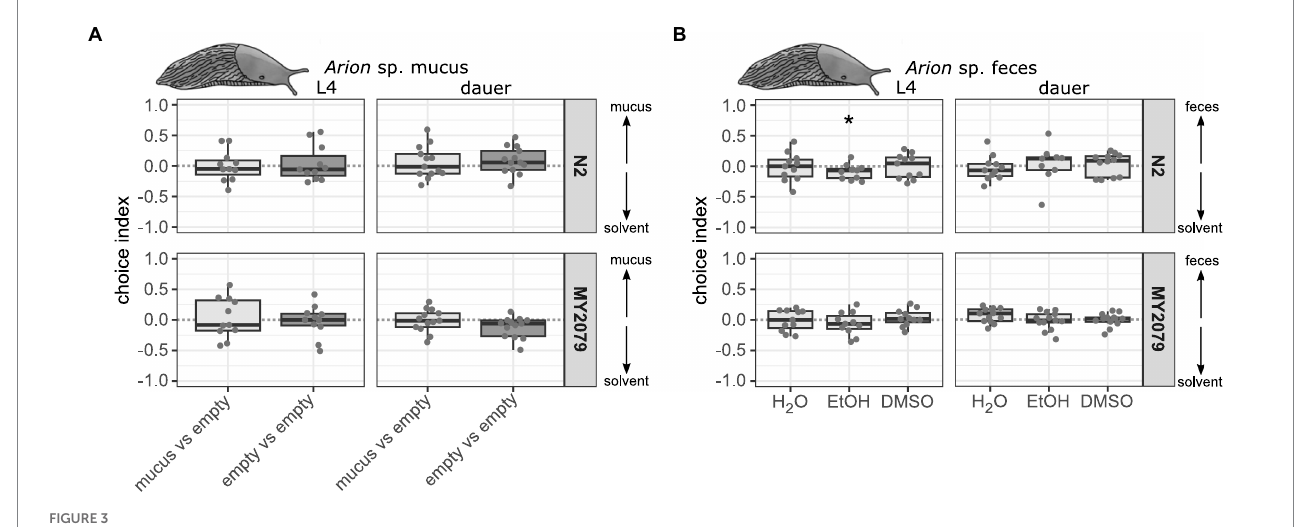
FIGURE 3 Caenorhabditis elegans strains N2 and MY2079 do not respond to Arion sp. mucus and L4 N2 is repelled by Arion sp. feces in ethanol. Chemotactic response of C. elegans N2 and MY2079 L4 and dauer larvae toward (A) , slug mucus applied directly from the Arion sp. foot compared to an empty plates side ( n = 11–13) and (B) , slug feces in three different solvents compared to the corresponding control solvent ( n = 9–13). A positive choice index indicates attraction to slug mucus or slug feces, a negative choice index indicates repulsion from slug mucus or slug feces, a choice index of 0 indicates equal choice of both sides. For comparison of choice indices with 0, the Wilcoxon signed-rank test with false discovery rate correction for multiple testing was applied. Data are presented as boxplots with the median as a thick horizontal line, the interquartile range as box, the whiskers as vertical lines, and each replicate depicted by a dot. Significance is designated to * p < 0.05. (B) From left to right each panel shows boxes representing deionized water (H 2 O), ethanol (EtOH), and dimethyl sulfoxide (DMSO) feces extracts (with 30–250 worms per